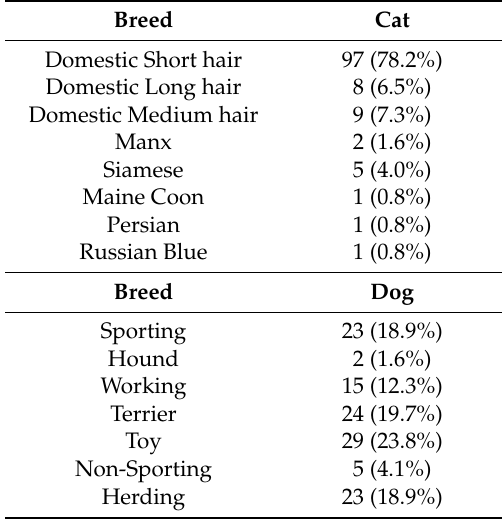
Table 4. Summary of the breeds of cats and dogs in the